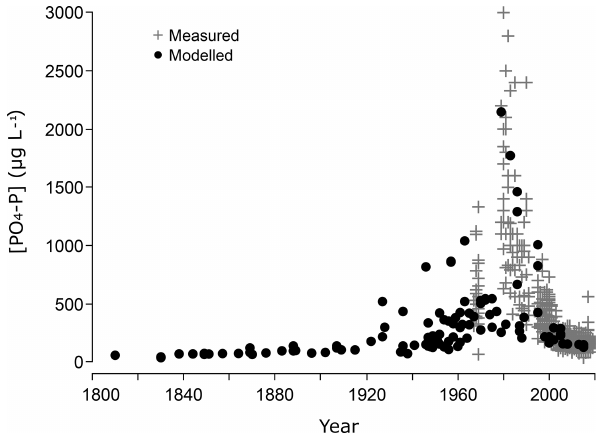
Figure 4. Measured (grey crosses; + ) and predicted (black points) PO 4 -P concentrations (µgL − 1 ) in the Scheldt River in Temse. The concentrations are calculated from the sediment phosphate sat- uration (DPS) of the tidal marshes at Old1 and Young1, using sediment–water model